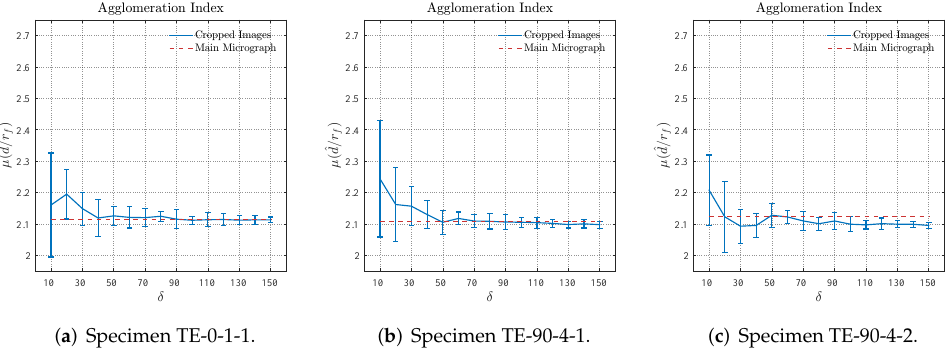
Figure 12. Mean value of ratio ˆ d / r f computed for different sizes of cropped